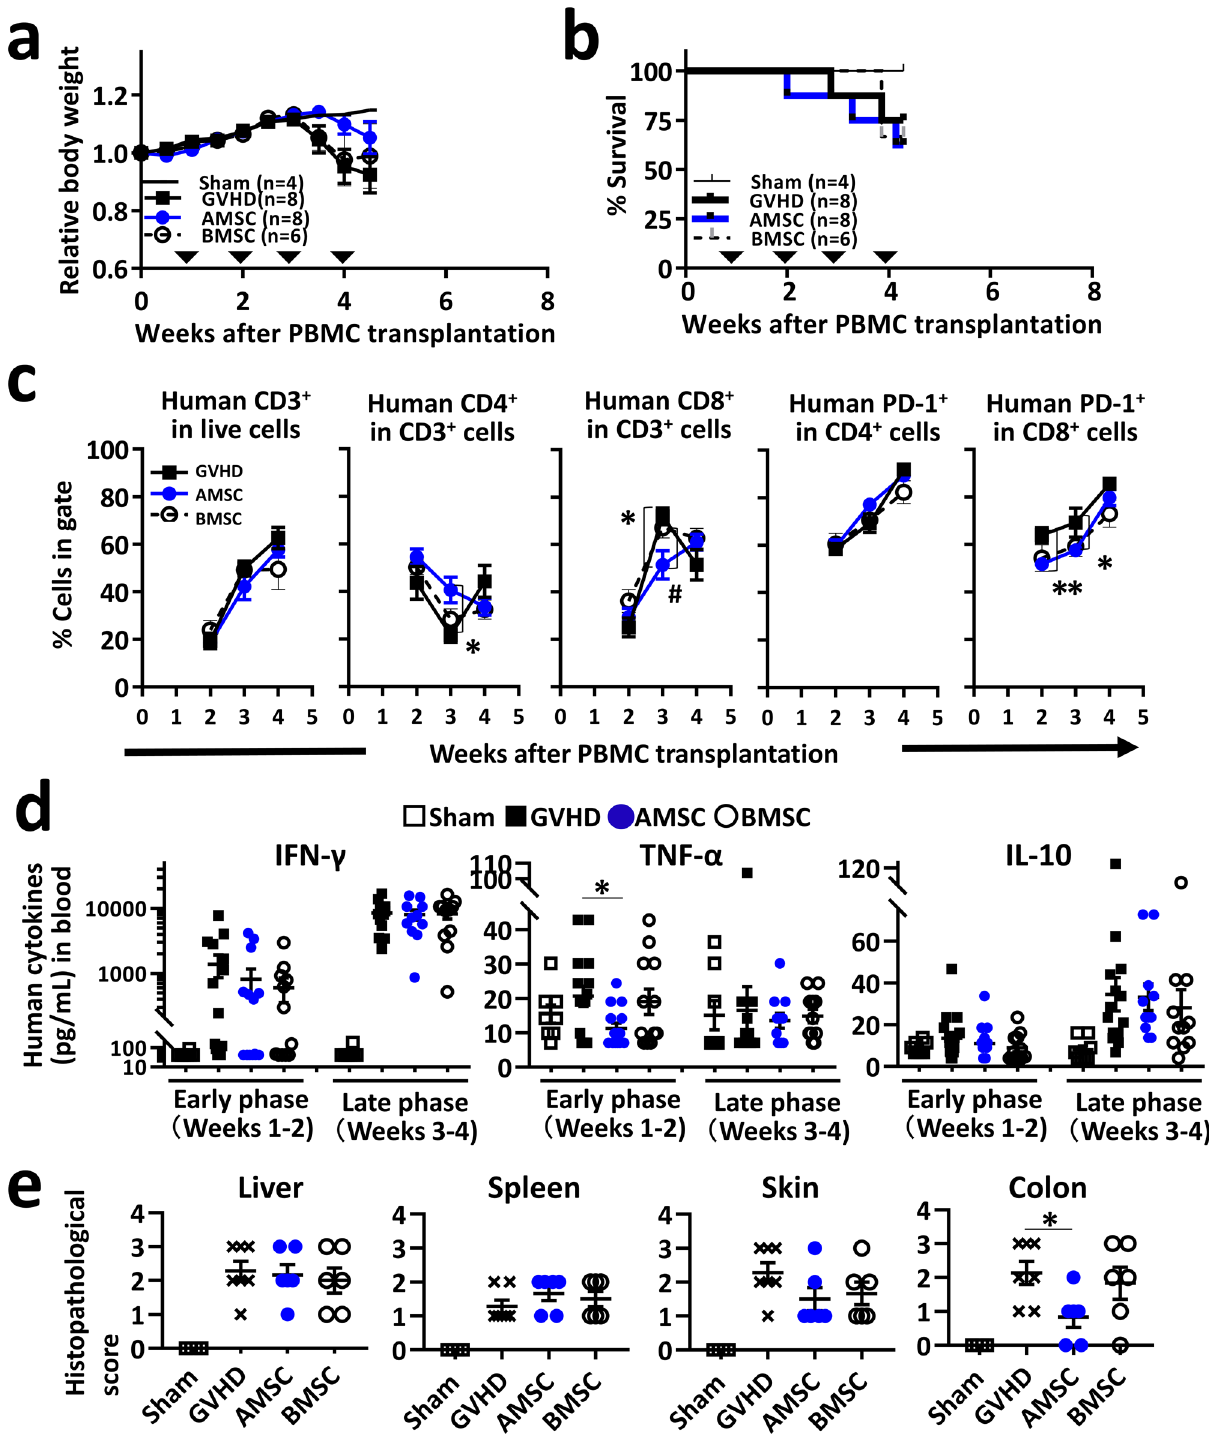
Figure 2. AMSC reduce the activity of human CD8 + T cells in xeno-GVHD mice. GVHD was induced by transplantation of 3 × 10 6 cells PBMC/mouse administered intravenously on week 0. Mice were administered 8 × 10 6 cells/kg AMSC (n = 8) or BMSC (n = 6) intravenously once a week from week 1 to 4 (inverted triangle). Sham (n = 4) and GVHD control (n = 8) mice were administered vehicle. In this middle-term experiment, survived mice were sacrificed at week 4. Representative data from one experiment shown. ( a , b ) Relative body weight and survival rate. ( c ) Human lymphocyte subpopulation in the peripheral blood of mice analyzed by flow cytometer at indicated time points. Populations of CD4 + or CD8 + in gated CD3 + T cells, and population of PD-1 + in gated CD4 + or CD8 + T cells were calculated. ( d ) Multibead-based immunoassay data of human IFN-γ, TNF-α, and IL-10 concentrations in the plasma collected in the early (weeks 1 ‒ 2) and late (weeks 3 ‒ 4) phases. ( e ) Histopathological scores of liver, spleen, skin, and colon tissues. Data are represented as mean ± SEM. Each symbol represents an individual mouse. * P < 0.05, ** P < 0.01 AMSC versus GVHD; # P < 0.05 AMSC versus